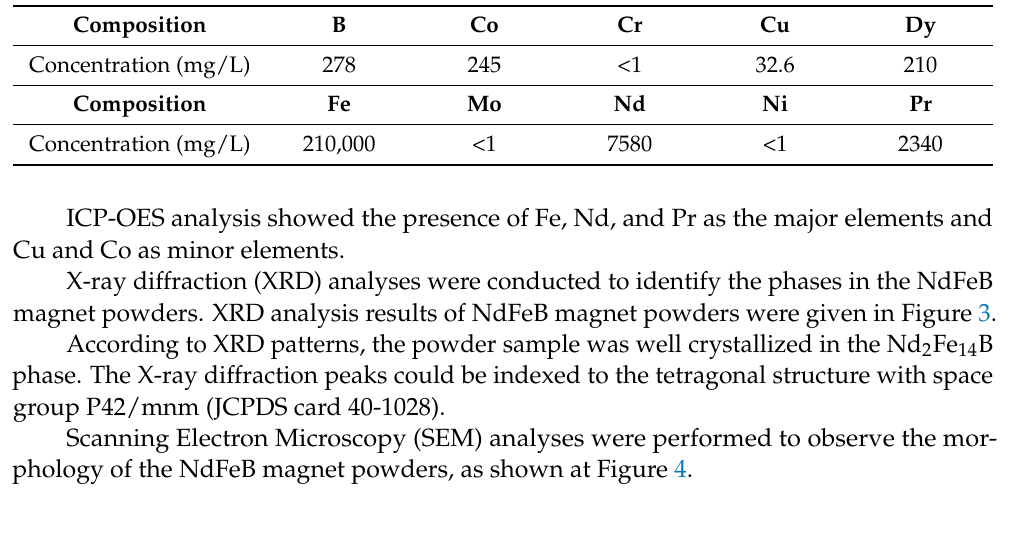
Table 3. Chemical composition of NdFeB magnet powders